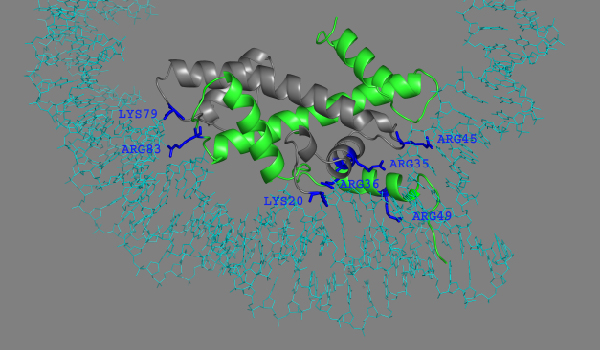
relative positions of histone H3 (in green), histone H4 (in grey) and DNA in the nucleosome core particle; the basic aminoacidic residues in direct contact with DNA are labelled and coloured in blue.